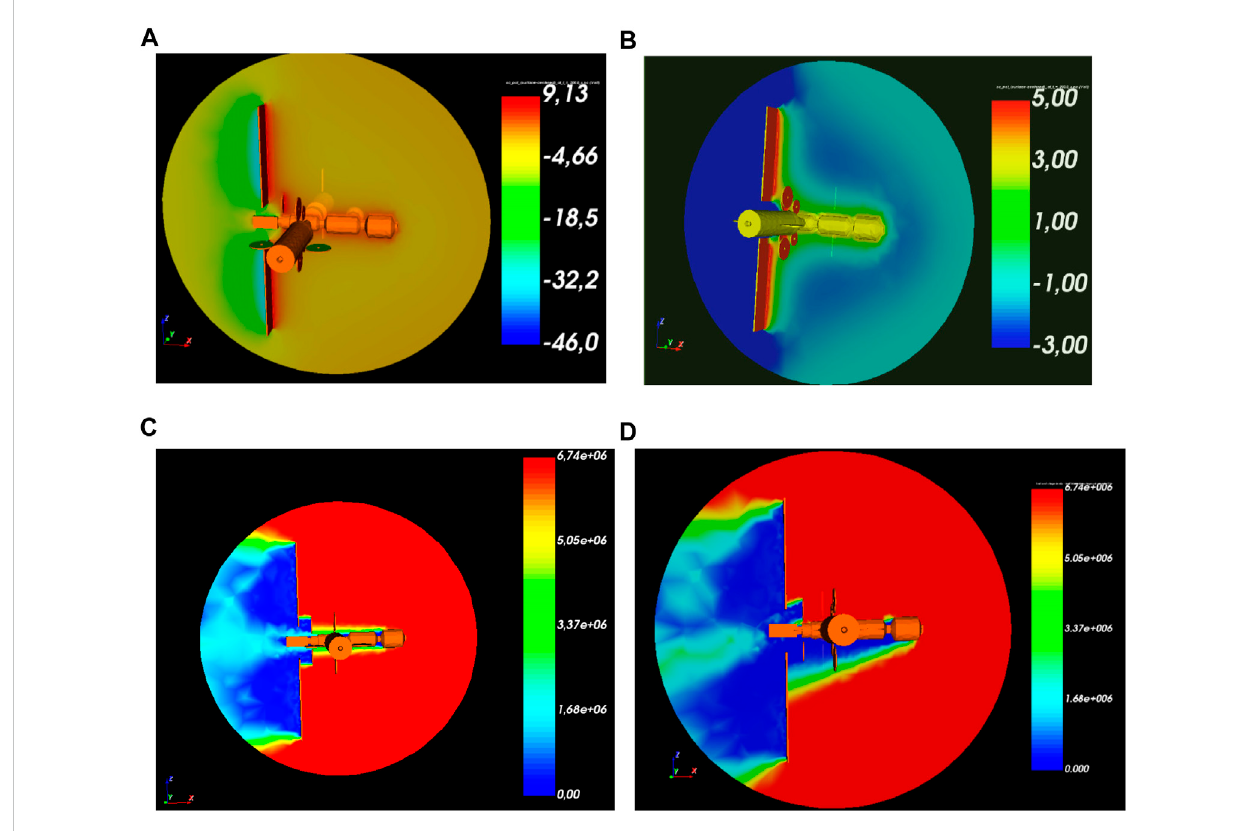
FIGURE 13 Top row: SPIS (Spacecraft Plasma Interaction System) simulation of the volume electrostatic potential distribution (in V) in the solar wind, with the Gateway aligned to the solar direction. (A) : Full potential scale. (B) : Potential scale saturated at +5/-3 V, to highlight the potential values away from the solar panels. Bottom row: Proton density (in m -3 )in the solar wind, with the Gateway aligned to the solar direction (C) and the Gateway main axis tilted by 20 ° with respect to the solar direction (D) . Note the plasma wake downstream of the